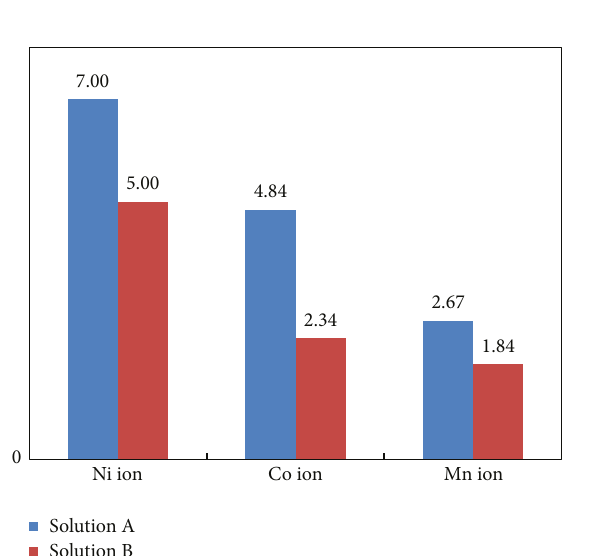
Figure 8: Ions adsorption capacity of DPRC.